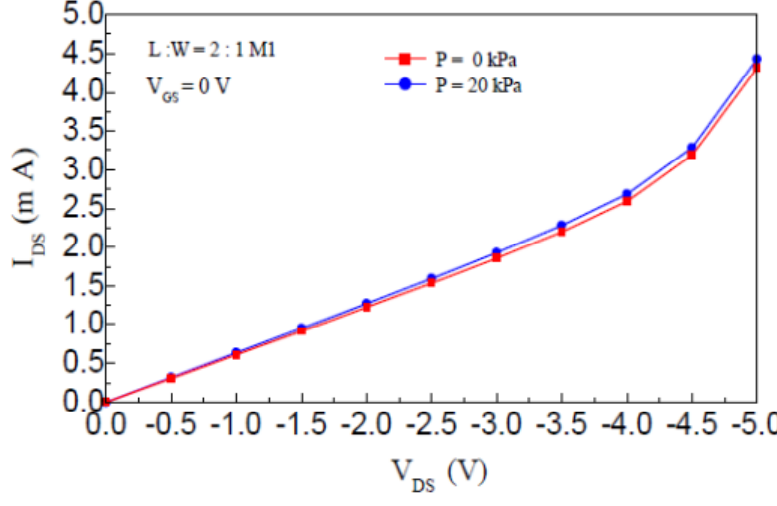
Figure 6. When P is constant, I heterojunction